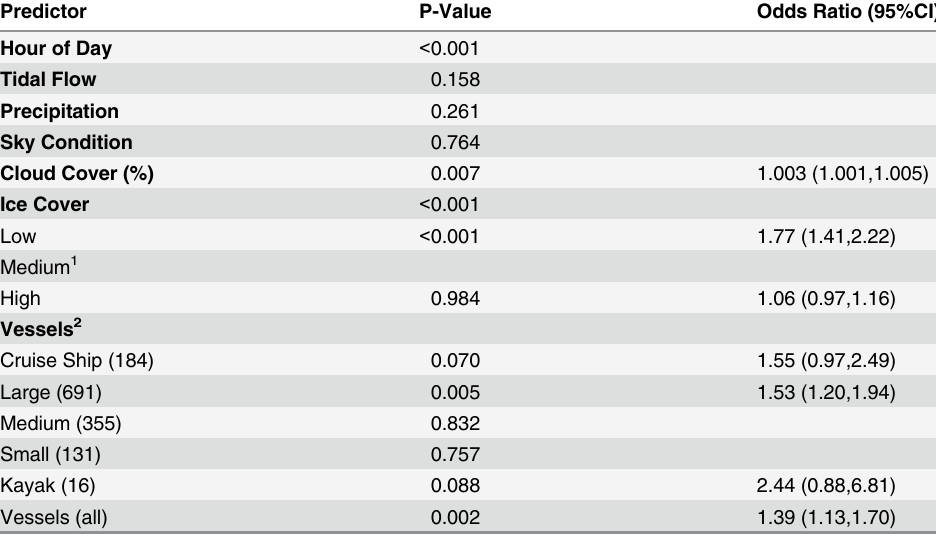
Table 7. Predictors related to the probability of an observation being an ‘ end-of-haulout ’ observation. Predictor P-Value Odds Ratio (95%CI) Hour of